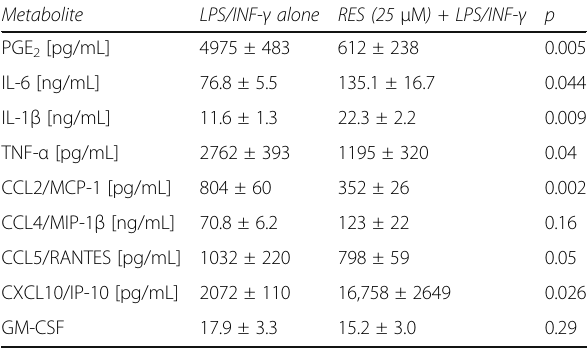
Table 3 RES-induced changes of the chemokine and cytokine profile in human